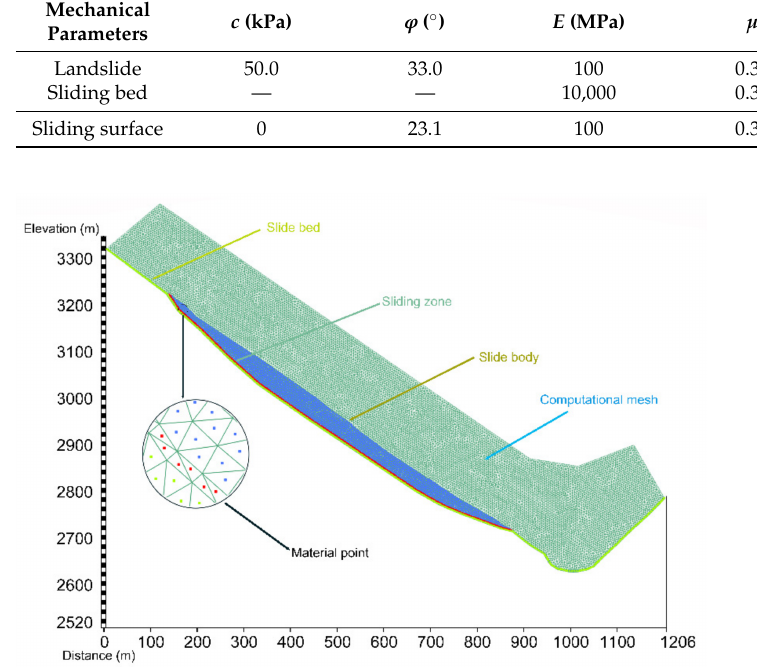
Figure 5. MPM model of the accumulation